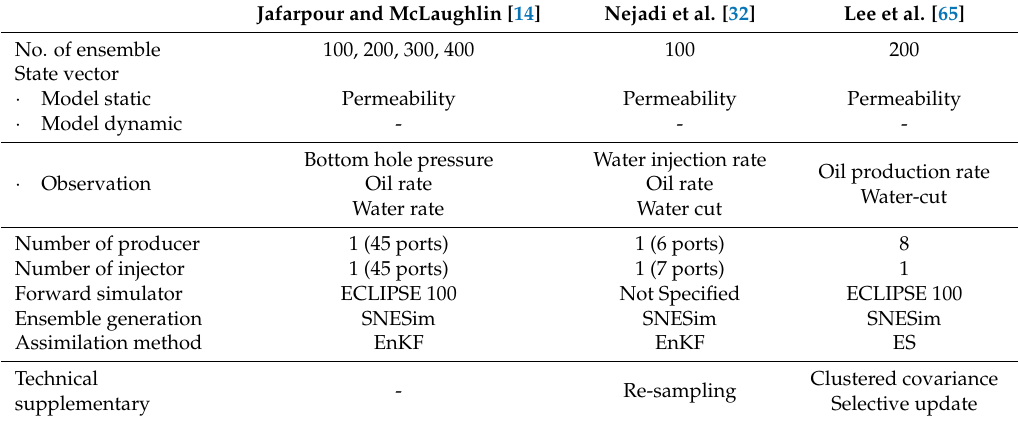
Table 3. Applications of ensemble based history matching for channelized